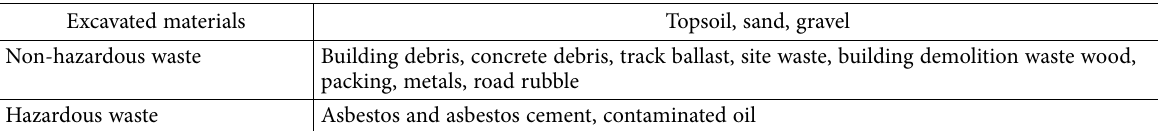
Table 1. Categories of C&D waste (Deloitte, 2016) Excavated materials Topsoil, sand,